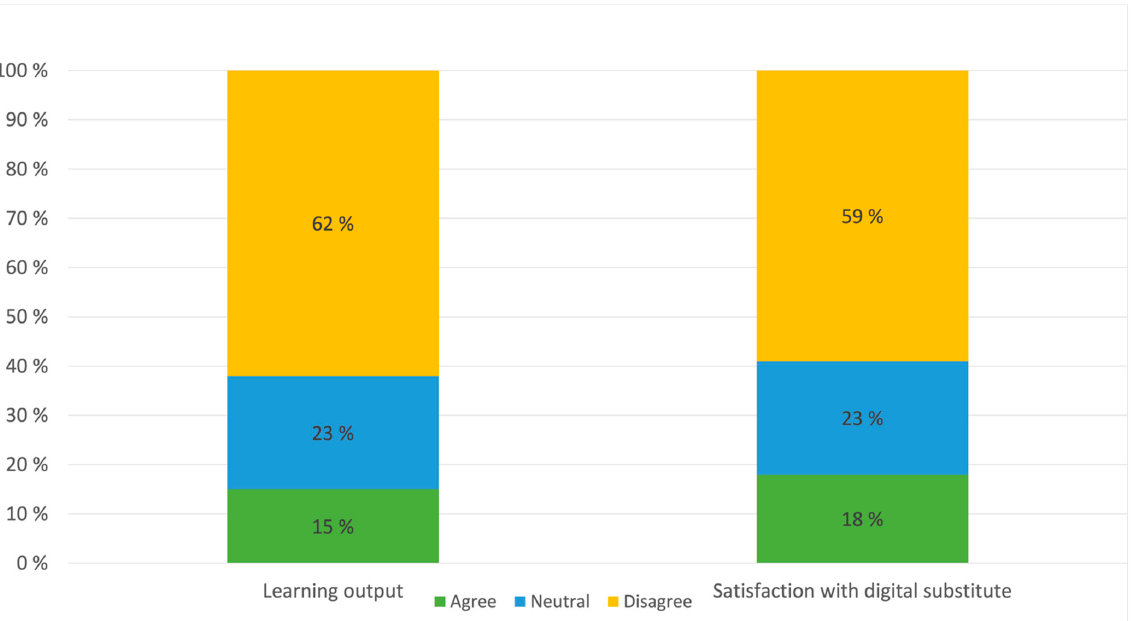
Figure 3. Likert scale mean value on student opinion regarding clinical and practical education de- pending on semester of study. Learning output: My learning output from digital clinical and prac- tical teaching has been the same as with physical teaching.